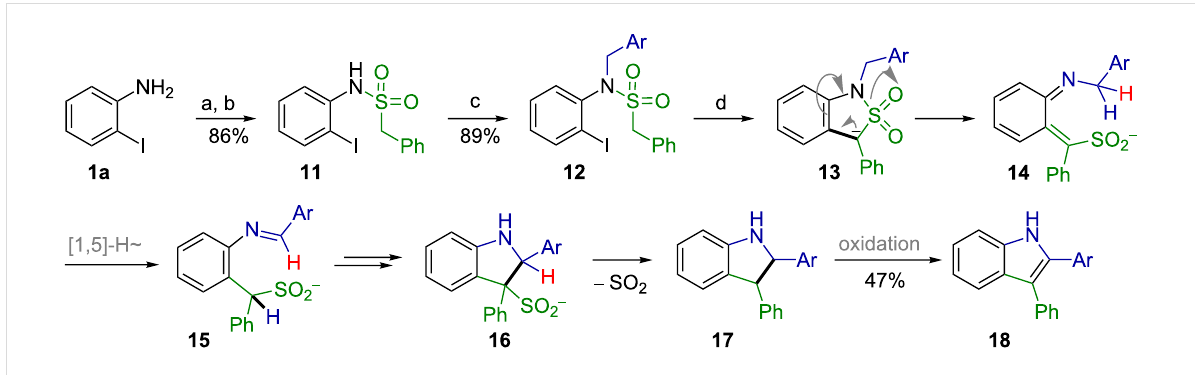
Scheme 5: Palladium-catalyzed transformation of N -(2-iodophenyl)- N -(4-methoxybenzyl-benzylsulfonamide 12 . Ar = 4-MeOC 6 H 4 ; a) BnSO 2 Cl, NMM, CH